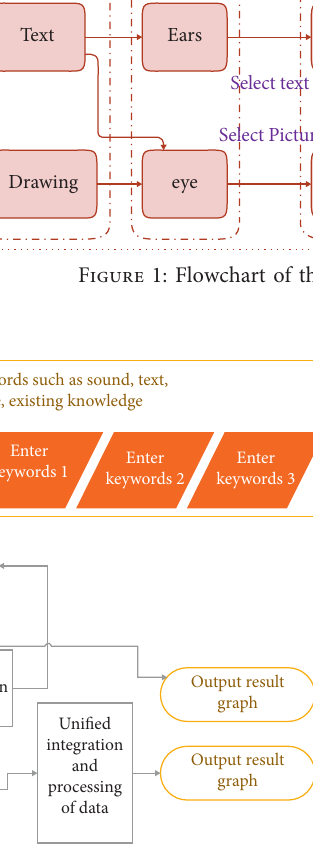
Figure 2: Discrete modeling flowchart for input